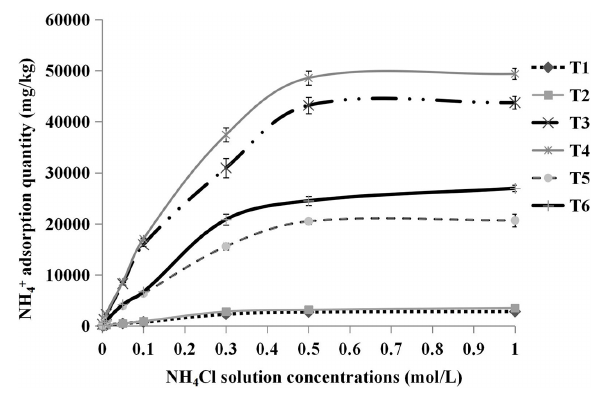
FIGURE 4 | Relationships between the concentrations of NH 4 Cl solution added and the total NH 4 + adsorption quantity. T1, sand; T2, sand + 1% HA; T3, cocopeat; T4, cocopeat + 1% HA; T5, 1:1 sand:cocopeat; T6, 1:1 sand:cocopeat + 1% HA.